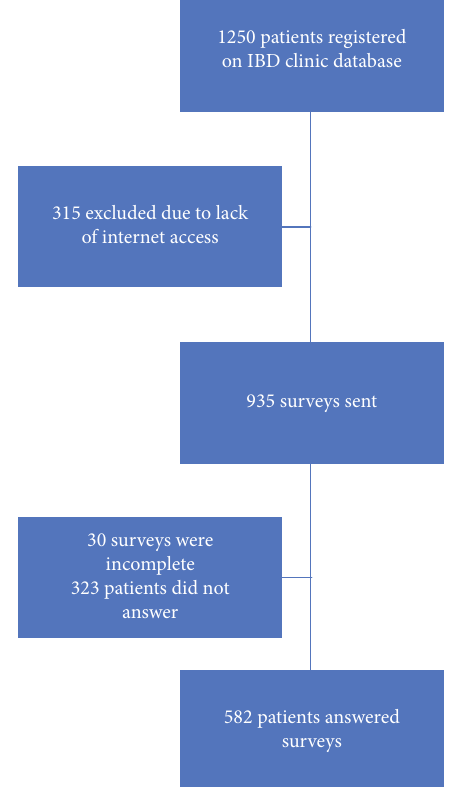
Figure 1: Flow chart showing patient selection process.